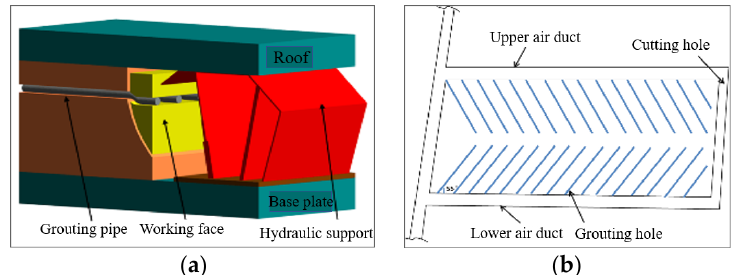
Figure 2. Layout of long-distance grouting: ( a ) simulated diagram; ( b ) plane graph.